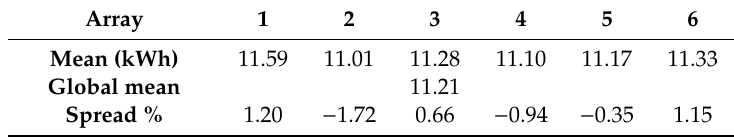
Figure 10. ( a ) Energy produced by array #4 in twelve months and its mean value as red line; ( b ) upper and lower BB 20 of array #4 in red color, and EMA 20 in magenta color. ( c ) and ( d ) refer to array #5. ( e ) and ( f ) refer to array #6. Table 4. Mean energy and spread with respect to the global mean for the twelve-months analysis.